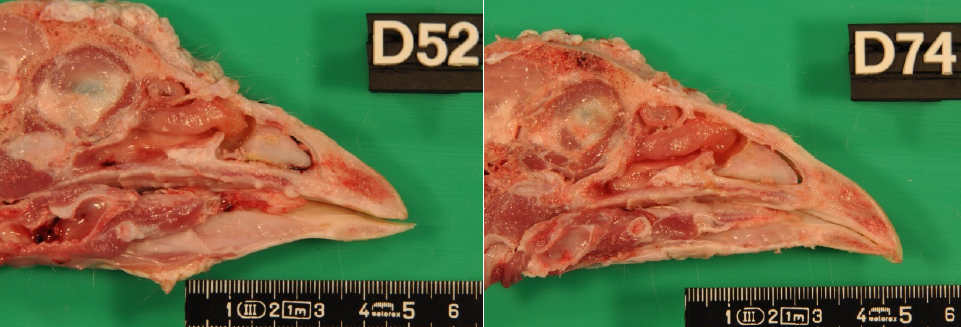
Figure A1. Macroscopic pictures of the heads of dead turkeys slaughtered after Phase 6 (138 day of life). On the left side (D52) is an infrared beak trimmed turkey and on the right side (D74) is the head of a turkey which had an integrated screed grinding wheel in the feed pan.